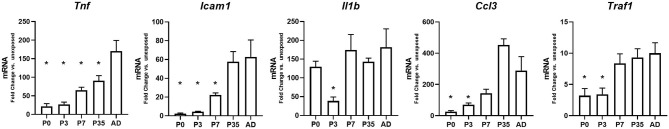
Endotoxemia induces developmentally-regulated hepatic expression of primary pro-inflammatory genes. Hepatic gene expression levels for primary innate immune pro-inflammatory genes 1-h post IP LPS at different developmental time points. *P < 0.05 vs. adult (AD) by 1-way ANOVA and Dunnet post-hoc test. Values are represented as fold change compared to their own unexposed control.